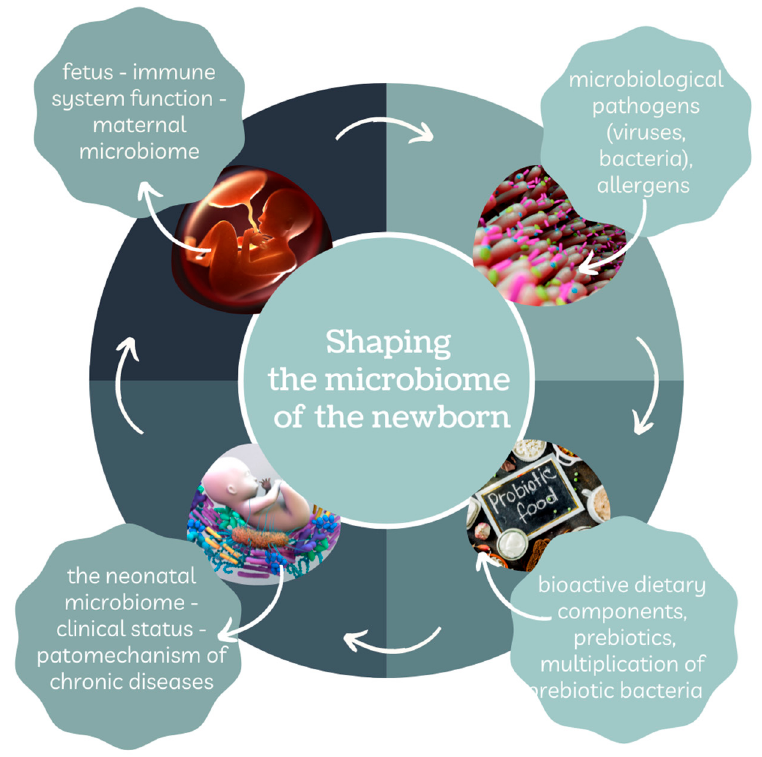
Figure 1. Shaping the newborn’s microbiome. Own elaboration based on [2].